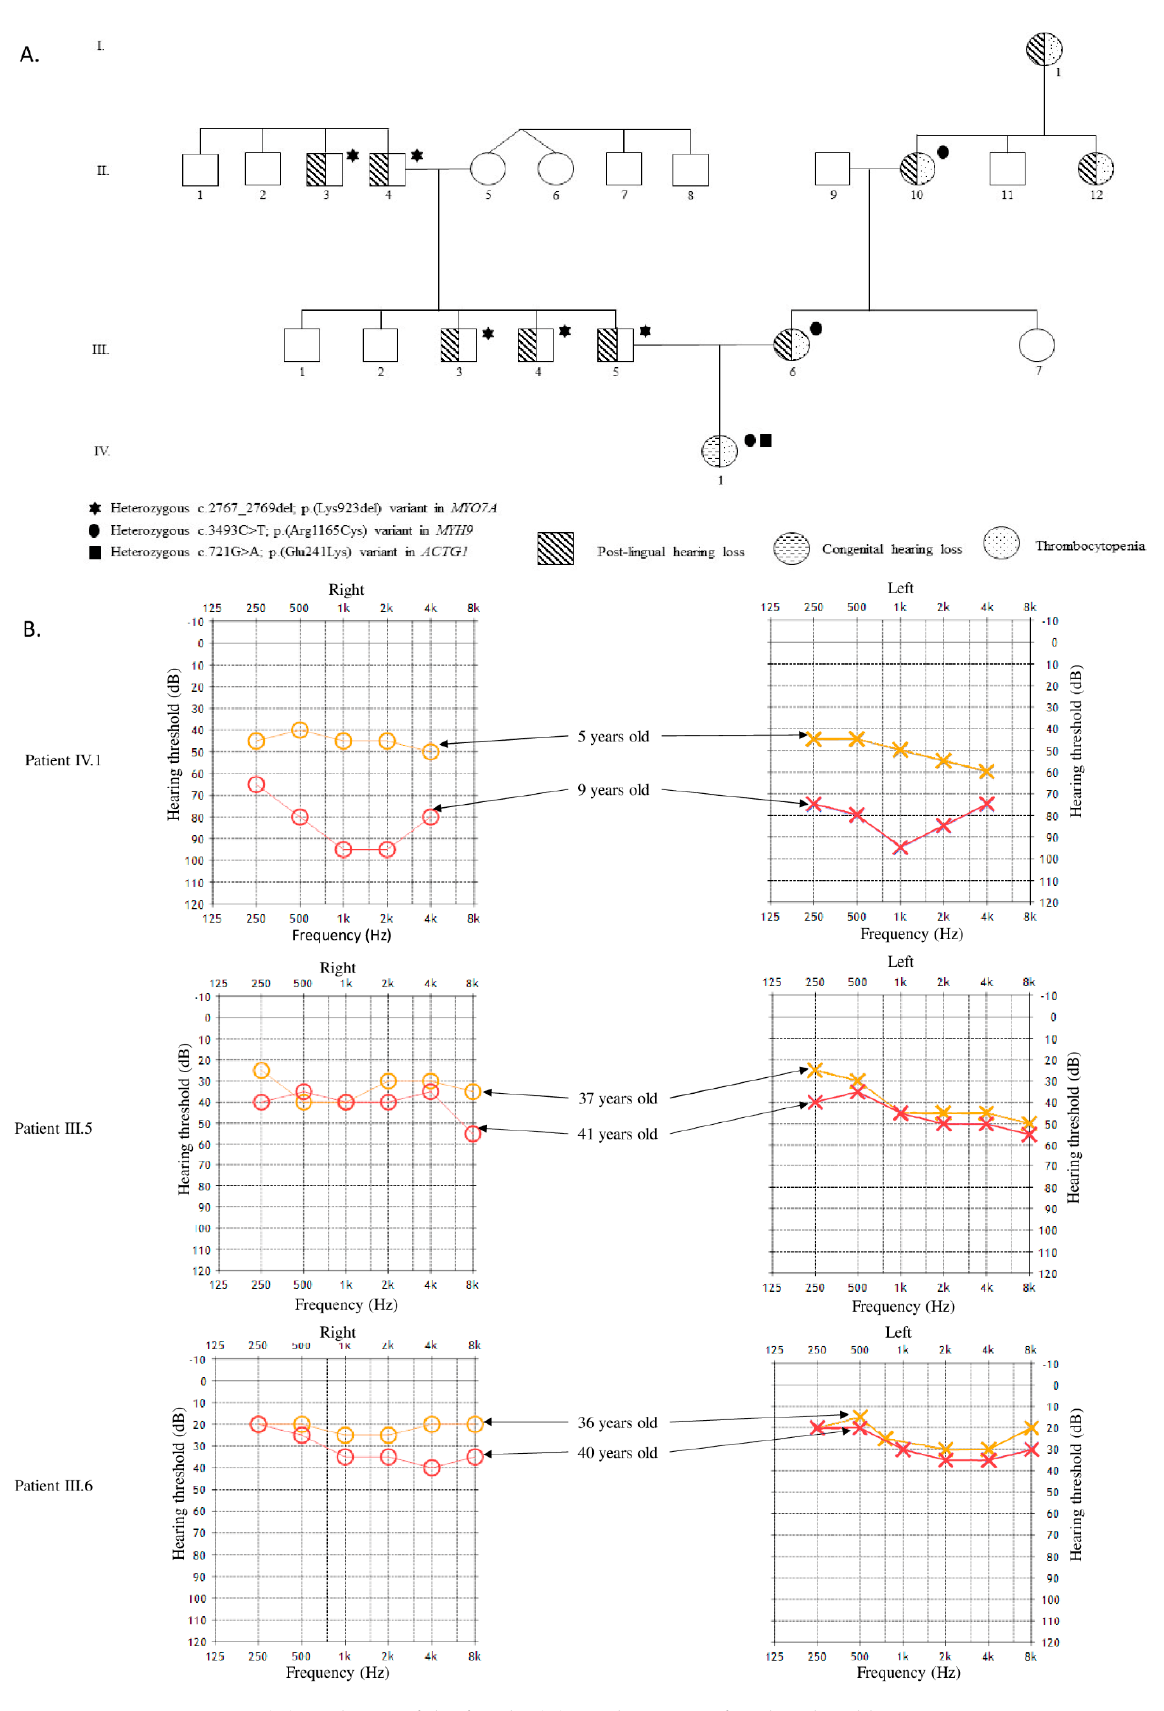
Figure 1. ( A ): Pedigree of the family. ( B ): Audiograms of proband and her parents.